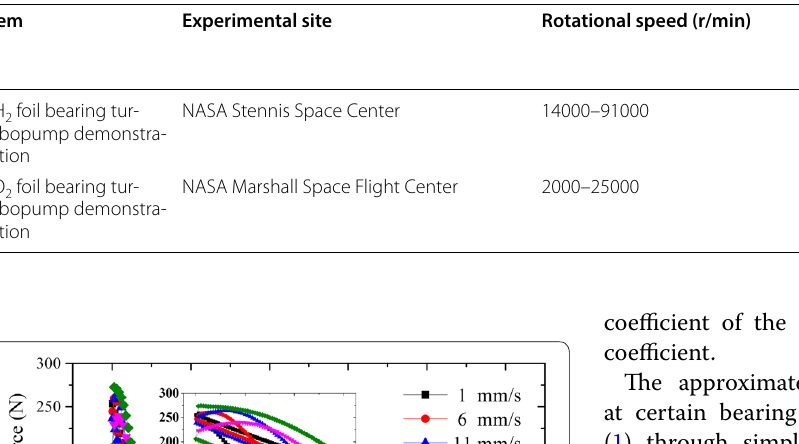
Table 2 Experimental highlights of NASA foil bearing turbopump demonstrations